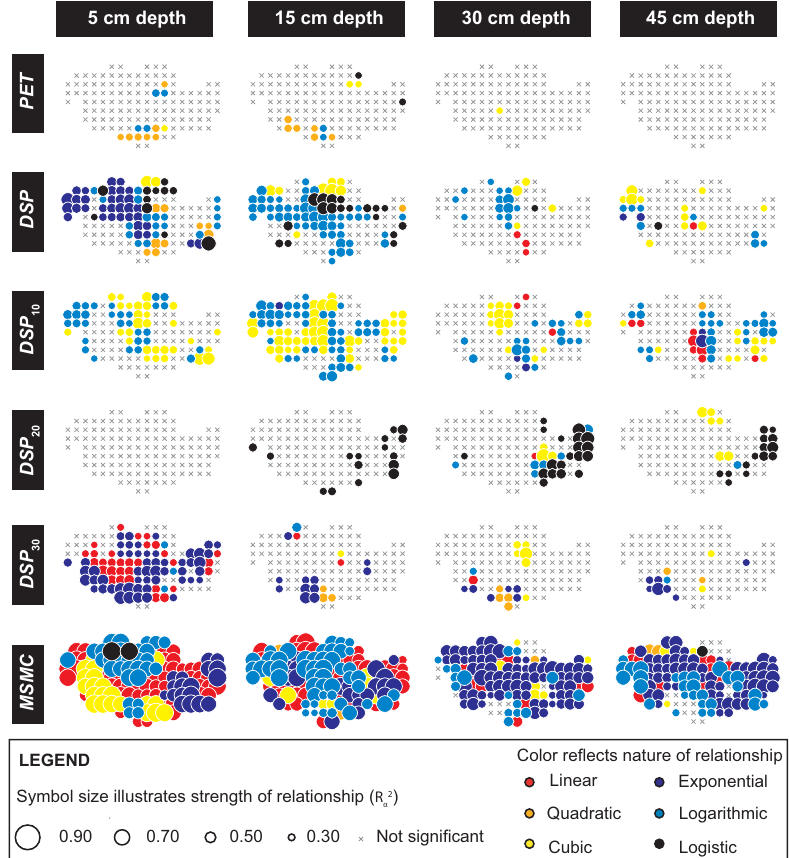
Fig. 5. Nature and strength of the relationships between point-scale soil moisture content, PET, DSP and DSP x indices ( x =0, 10, 20 or 30mm/d) used as surrogates for AMCs, and θ mean used as a surrogate for the Hermine catchment macro-state. R 2 α refers to the adjusted R